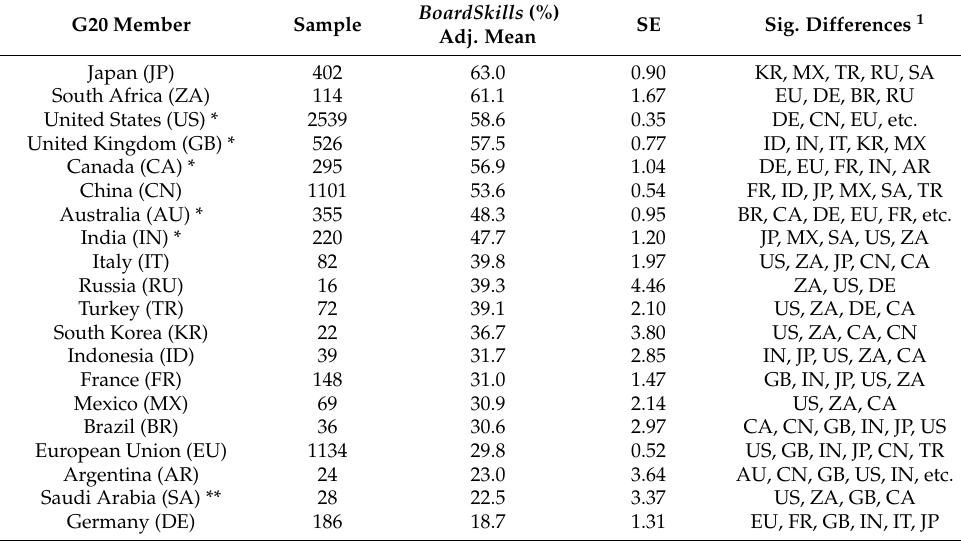
Table 7. The analysis of covariance of BoardSkills by country/group of countries, adjusted for company size, in descending order.